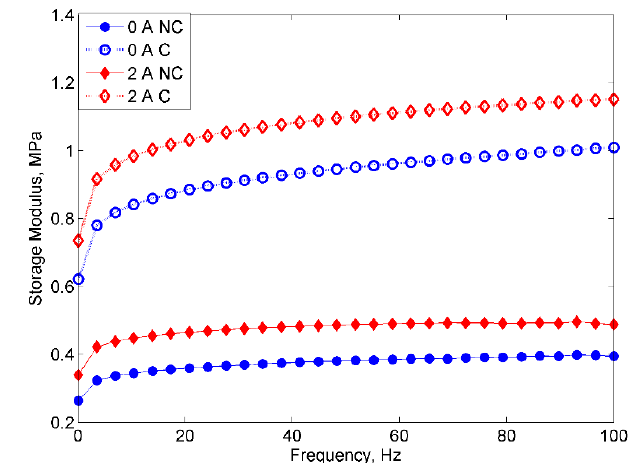
Figure 6. Storage modulus vs. frequency for MRE with non-corroded (NC) and corroded (C) CIPs at off- and on-state conditions.